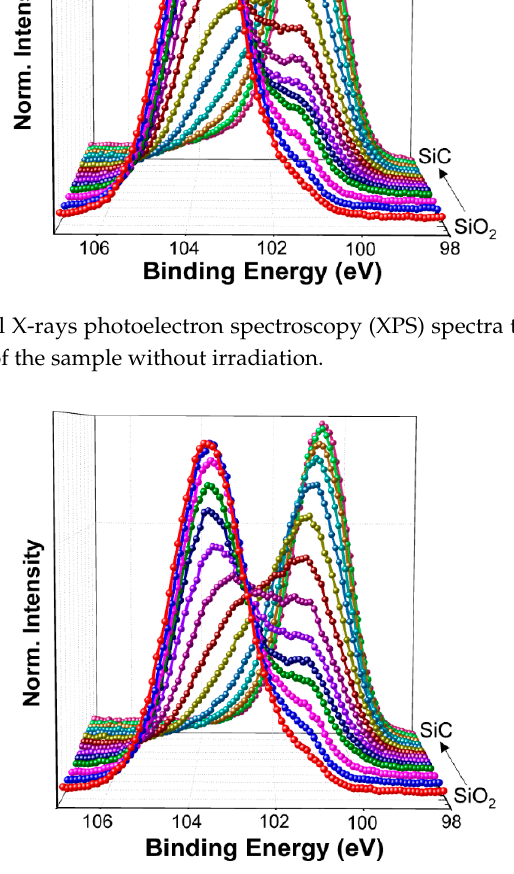
Figure 8. Si 2p core level XPS spectra taken from the different depths of the transition of the sample with the irradiation dose of 5 × 10 13 p/cm 2 .